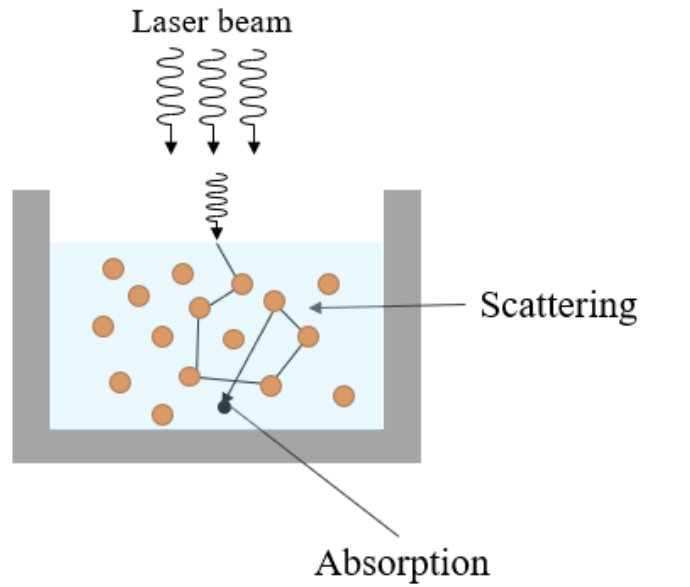
Figure 6. Light scattering and absorption phenomena in a media charged in ceramic particles. Adapted from [49].